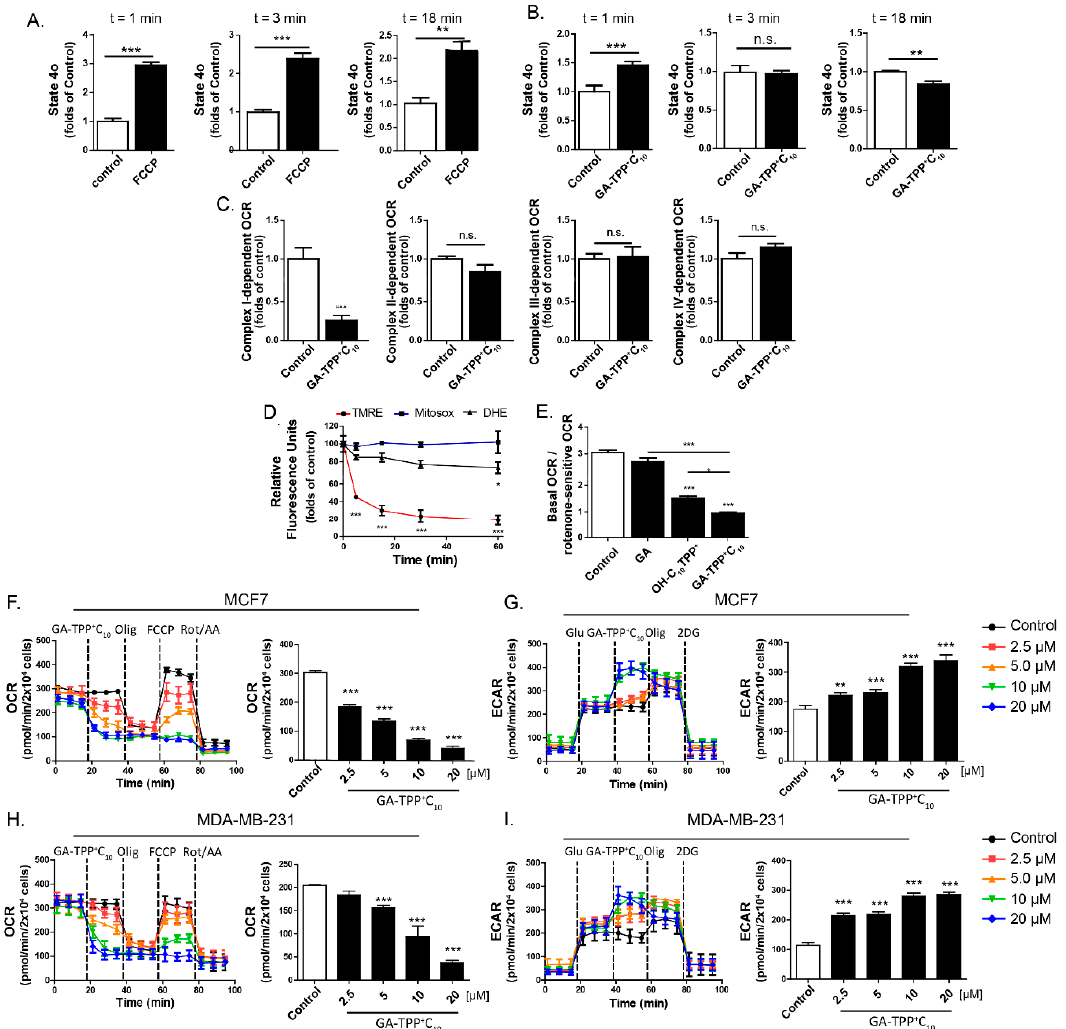
Figure 3. GA-TPP + C 10 inhibits Complex I-dependent respiration and leads to a glycolytic phenotype in BC cells. ( A ) Effect of 1 µM FCCP and ( B ) 10 µM GA-TPP + C 10 on the oxygen consumption rate (OCR) after 1–18 min in the apparent 4o state of the intact MCF7 cells. ( C ) Effect of 10 µM GA-TPP + C 10 on each respiratory complex-dependent OCR in the permeabilized MCF7 cells using a Clark electrode. ( D ) Effect of 10 µM GA-TPP + C 10 on ΔΨ m and mitochondrial and intracellular ROS production in MCF7 cells using TMEM and DHE probes, respectively. ( E ) Effect of 10 µM GA-TPP + C 10 , gentisic acid, and OH-C 10 TPP + on Complex I-dependent OCR. ( F , G ) GA-TPP + C 10 decreases the maximal OCR and increases the glycolysis-dependent extracellular acidification rate (ECAR) value in MCF7 and (H-I) MDA-MB-231 cells, measured with a Seahorse system. Values are expressed as the mean ± SEM of three independent experiments. * p < 0.05, ** p < 0.01, *** p < 0.001 vs. the control (DMSO). + Consistent with this finding, GA-TPP C 10 in intact BC cells inhibited basal and maximal mitochondrial (Figures3F–IandS5). Notably,